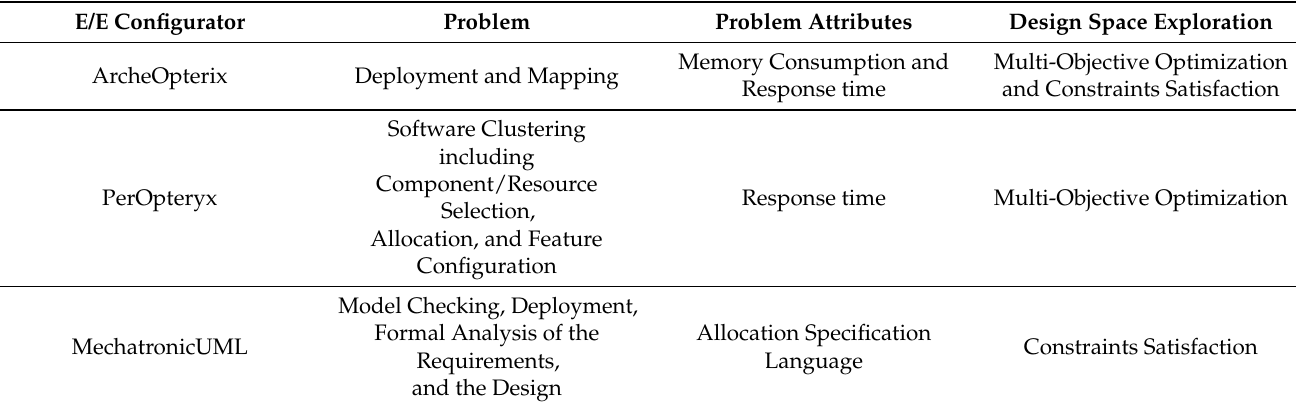
Table 1. Problem’s type, problem’s attributes, and DSE type of the above-mentioned open-source